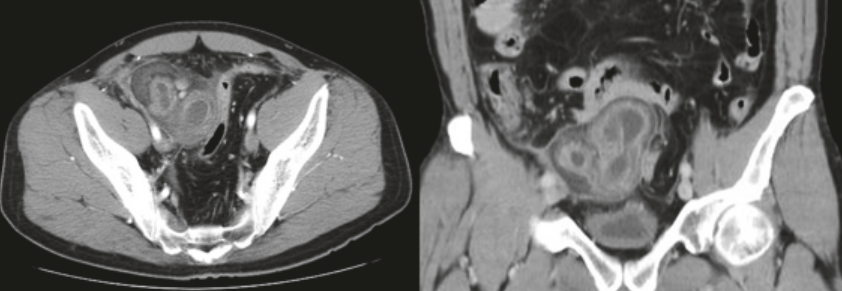
Figure 1: A computed tomography (CT) image revealed irregular polycystic mass connected to small intestine measuring 7.5cm in a diameter in the lower abdomen.